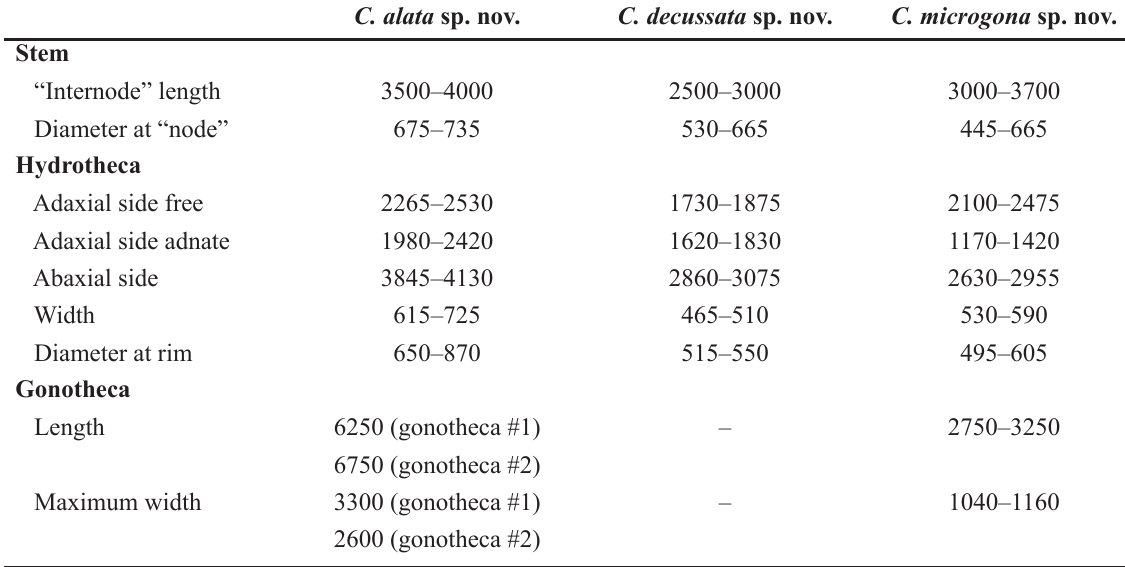
Table 1. Measurements of species of Caledoniana gen. nov., in